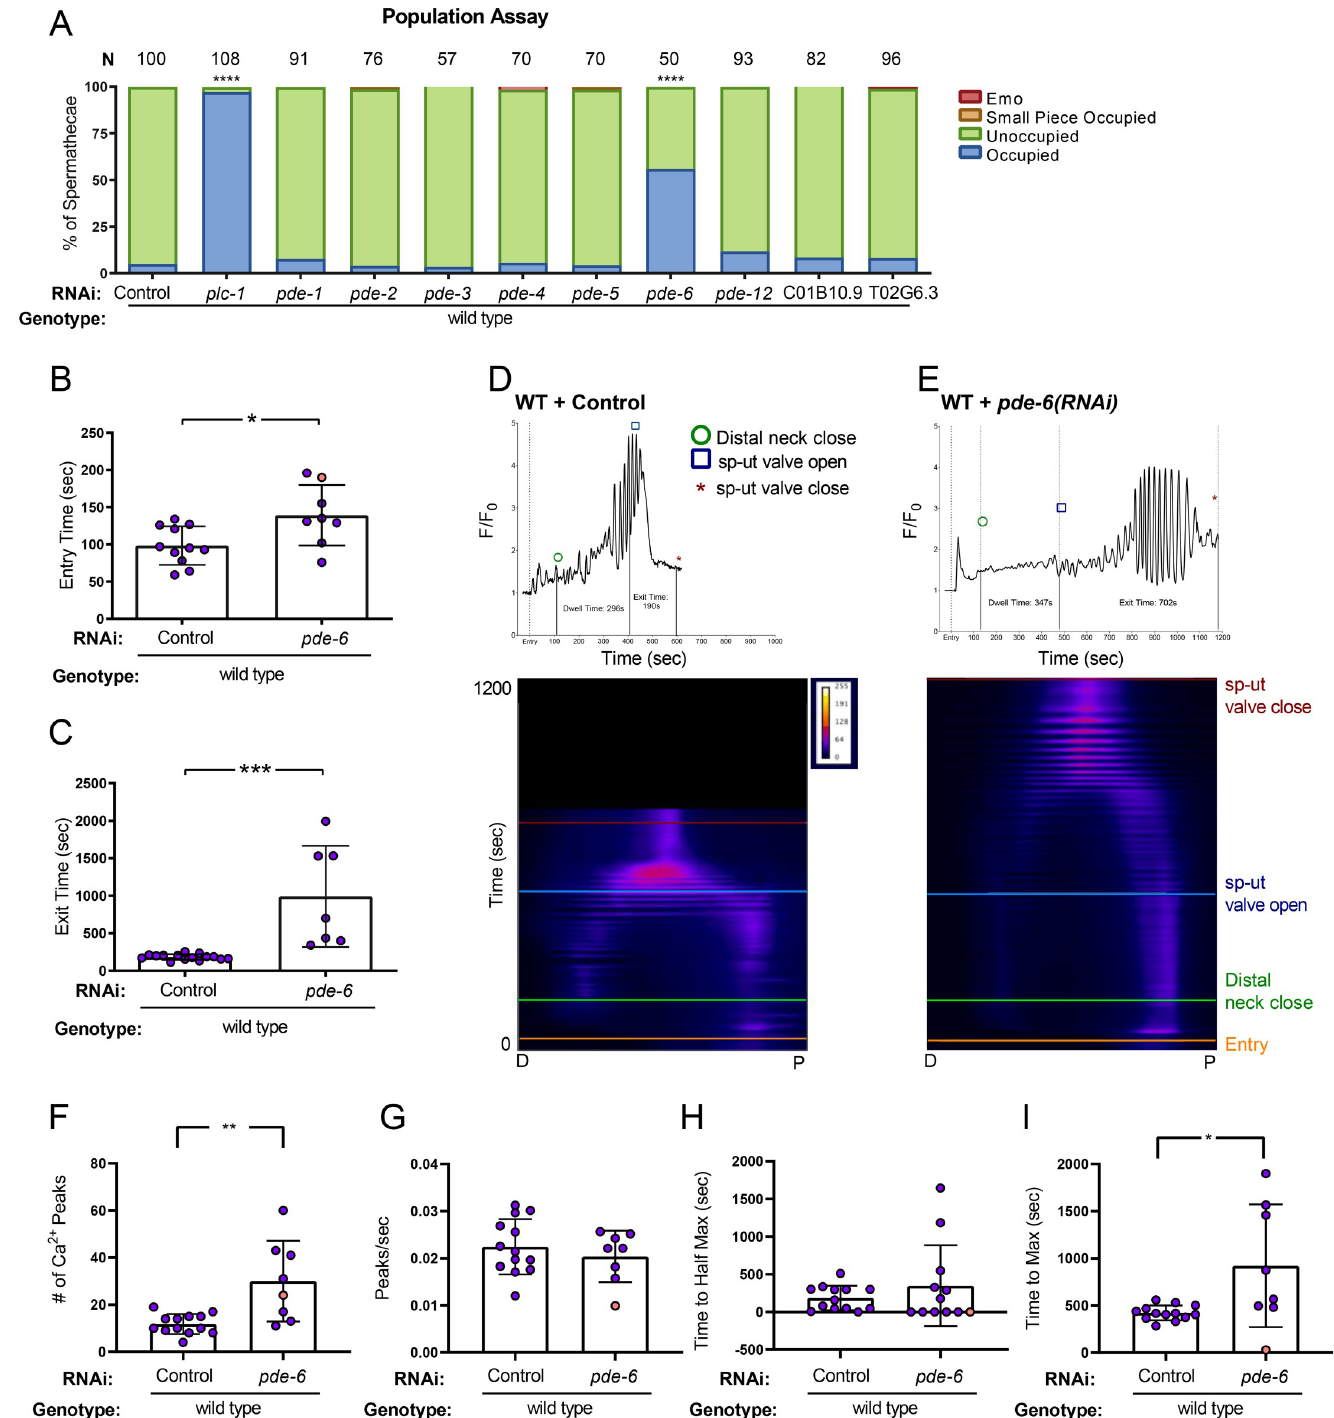
Fig 5. Phosphodiesterase PDE-6 is necessary for normal transit times and Ca 2+ dynamics. (A) population assay of wild type animals grown on control RNAi, plc-1 (RNAi) , pde-1(RNAi) , pde-2(RNAi) , pde-3(RNAi) , pde-4(RNAi) , pde-5(RNAi) , pde-6(RNAi) , pde-12(RNAi) , C01B10.9 and T02G6.3. Spermathecae were scored for the presence or absence of an embryo (occupied or unoccupied), presence of a fragment of an embryo (small piece occupied), or the presence of endomitotic oocytes in the gonad arm (emo) phenotypes. The total number of unoccupied spermatheca was compared to the sum of all other phenotypes using the Fisher’s exact t -test. N is the total number of spermathecae counted. Control RNAi was compared to all other RNAi treatments. Entry time (B) and exit time (C) were compared using Fisher’s exact t -test (two dimensional x 2 analysis). (B,C) Values are color coded corresponding to transit phenotype (purple: successful exit, orange: traps. Representative